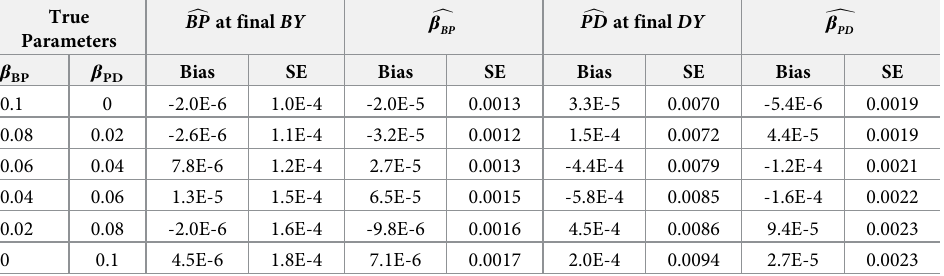
Table 2. Simulation results of parameter optimization using Monte Carlo binomial sampling, 1000 iterations. True